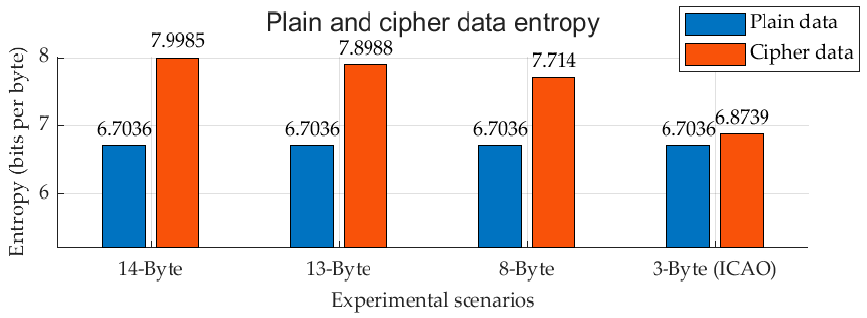
Figure 8. Plain and cipher data entropy.